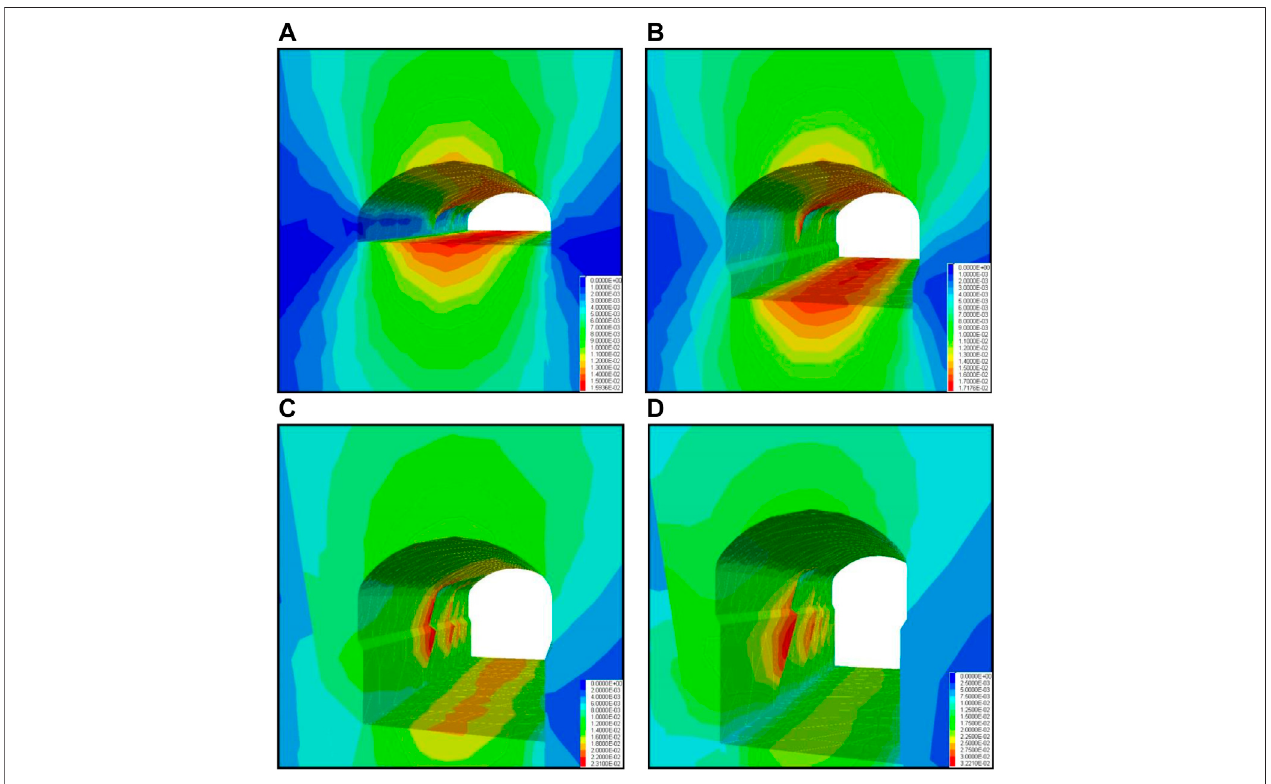
FIGURE 8 | Deformation distribution of surrounding rock masses at the upstream sidewall after sequential excavations under nonsupported conditions (Unit: m). (A) step 1, (B) step 2, (C) step 3, and (D) step 4.